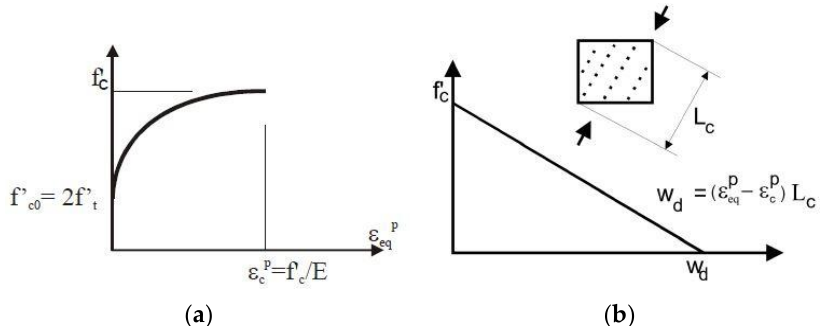
Figure 24. ( a ) Compressive hardening and ( b ) softening concrete constitutive law [23].